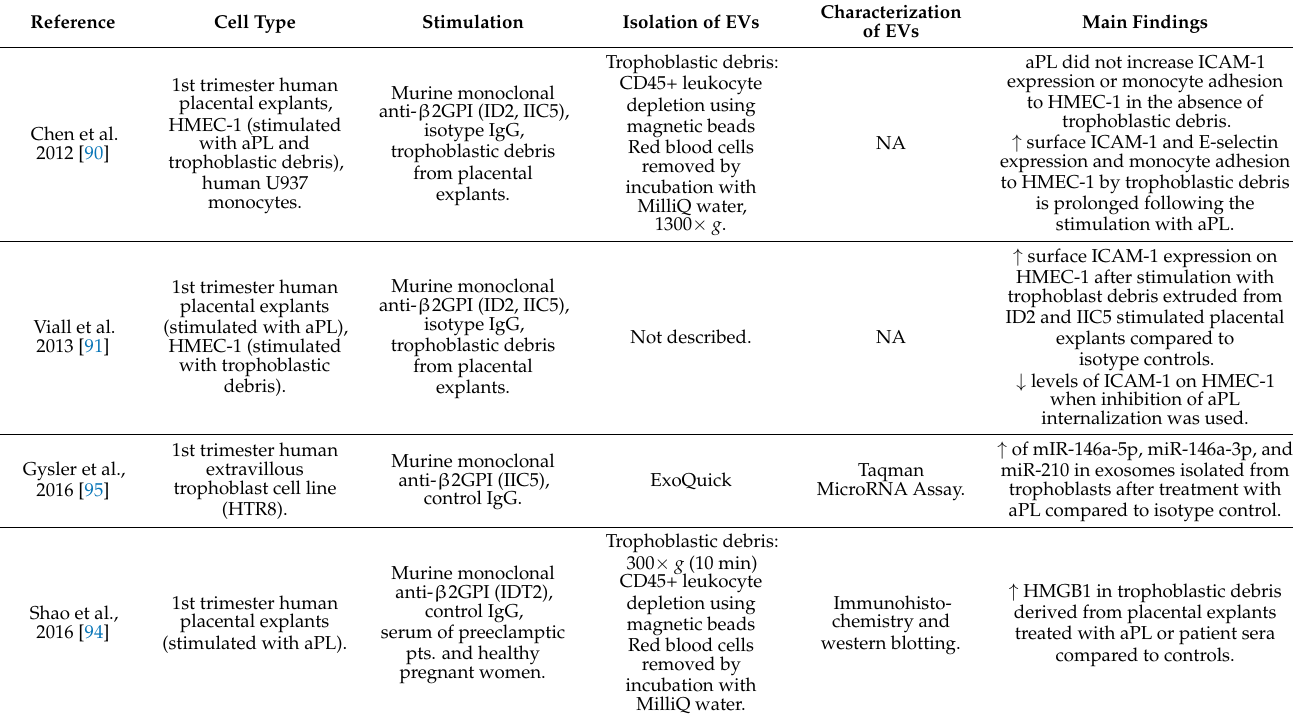
Table 4. Isolation, quantification and characterization of EVs derived from placental explants after stimulation with aPL and their effect on endothelial cells